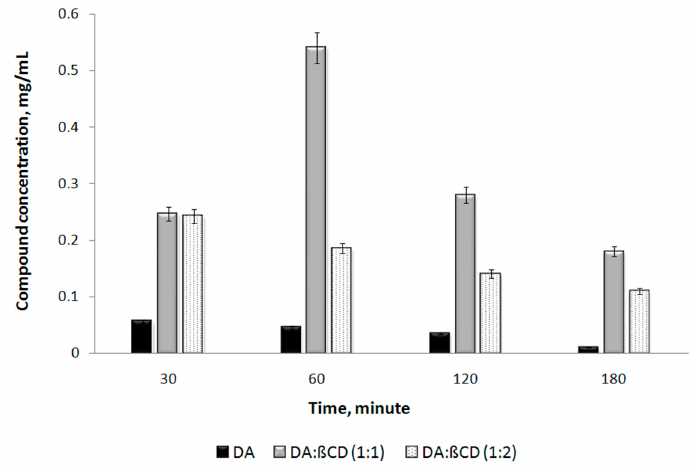
Figure 14. DA concentration in rats’ plasma as a function of time and types of administered compound.